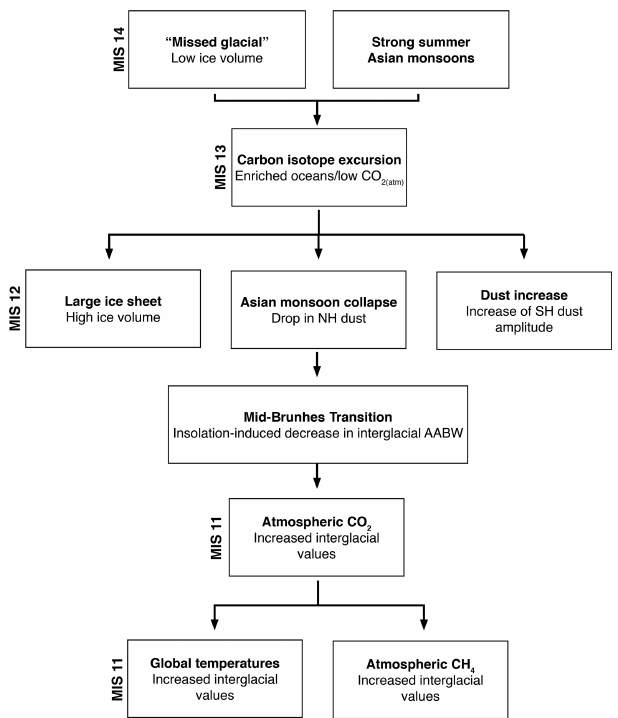
Figure 13. Schematic representation of the sequence of events lead- ing to the Mid-Brunhes Transition. Corresponding Marine Isotope Stages are located on the left side of each row. Boxes in a row indi- cate synchronous